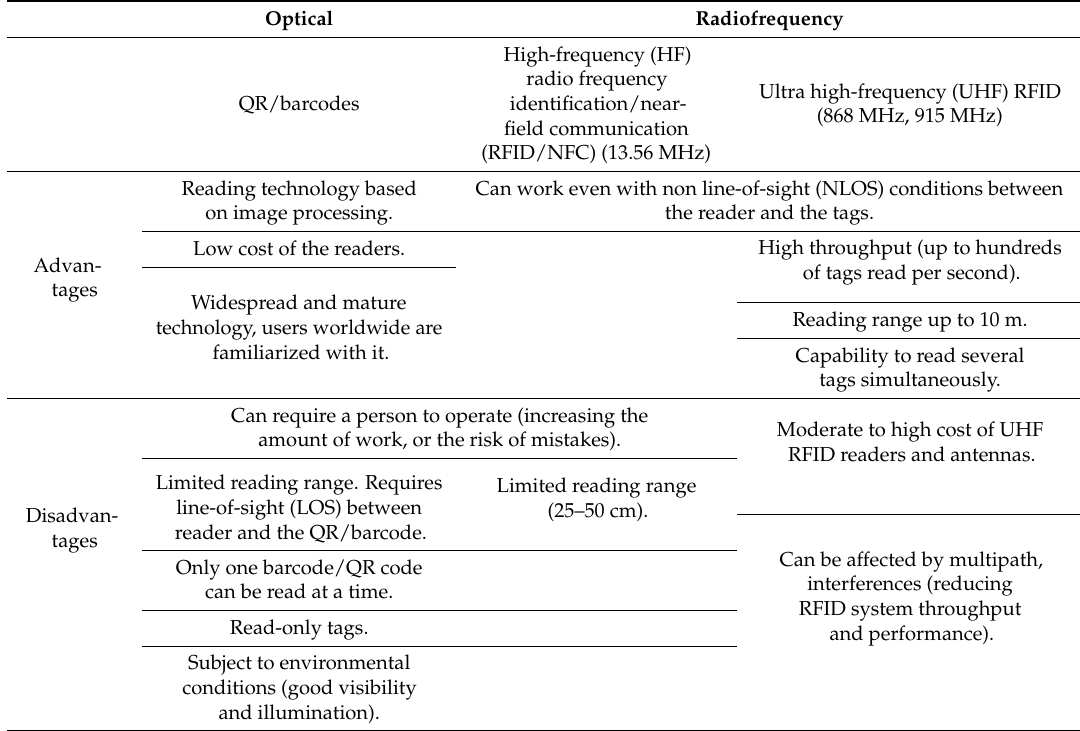
Table 1. Summary of advantages and disadvantages of optical and radiofrequency technologies for people and asset tracking and monitoring [8,12–16].